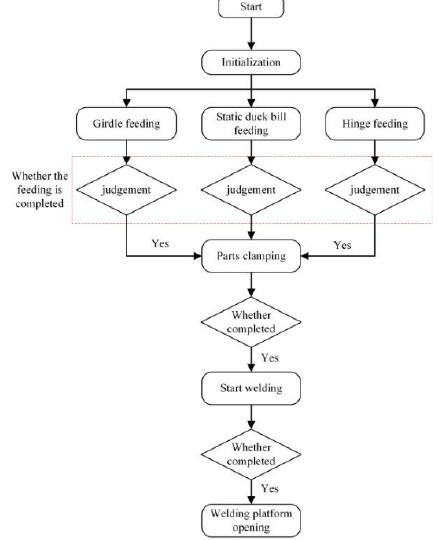
Figure 16. Control system flow chart.